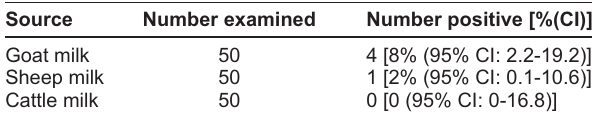
Table-1: Percent positivity of DNA in animal milk T. gondii samples as for detected by PCR.